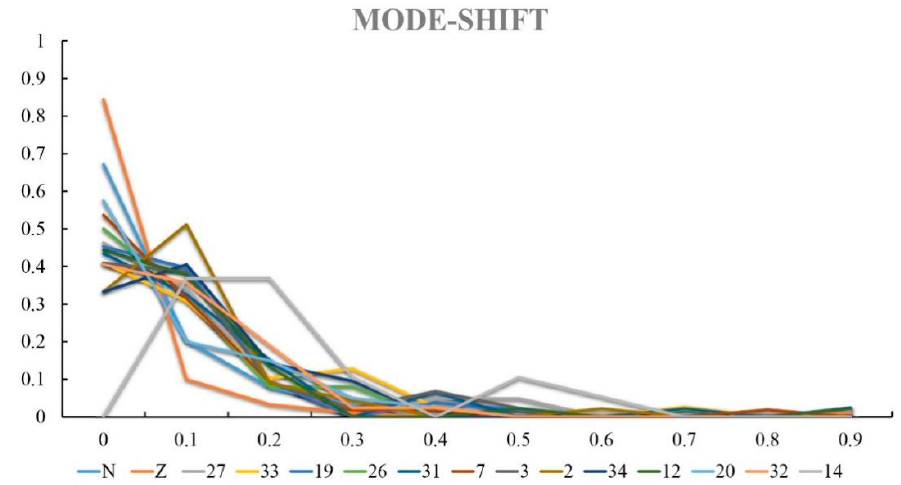
Figure 4. Distribution map of allele frequency. “N” and “Z” stand for crabs caught from Nantong and Zhoushan.